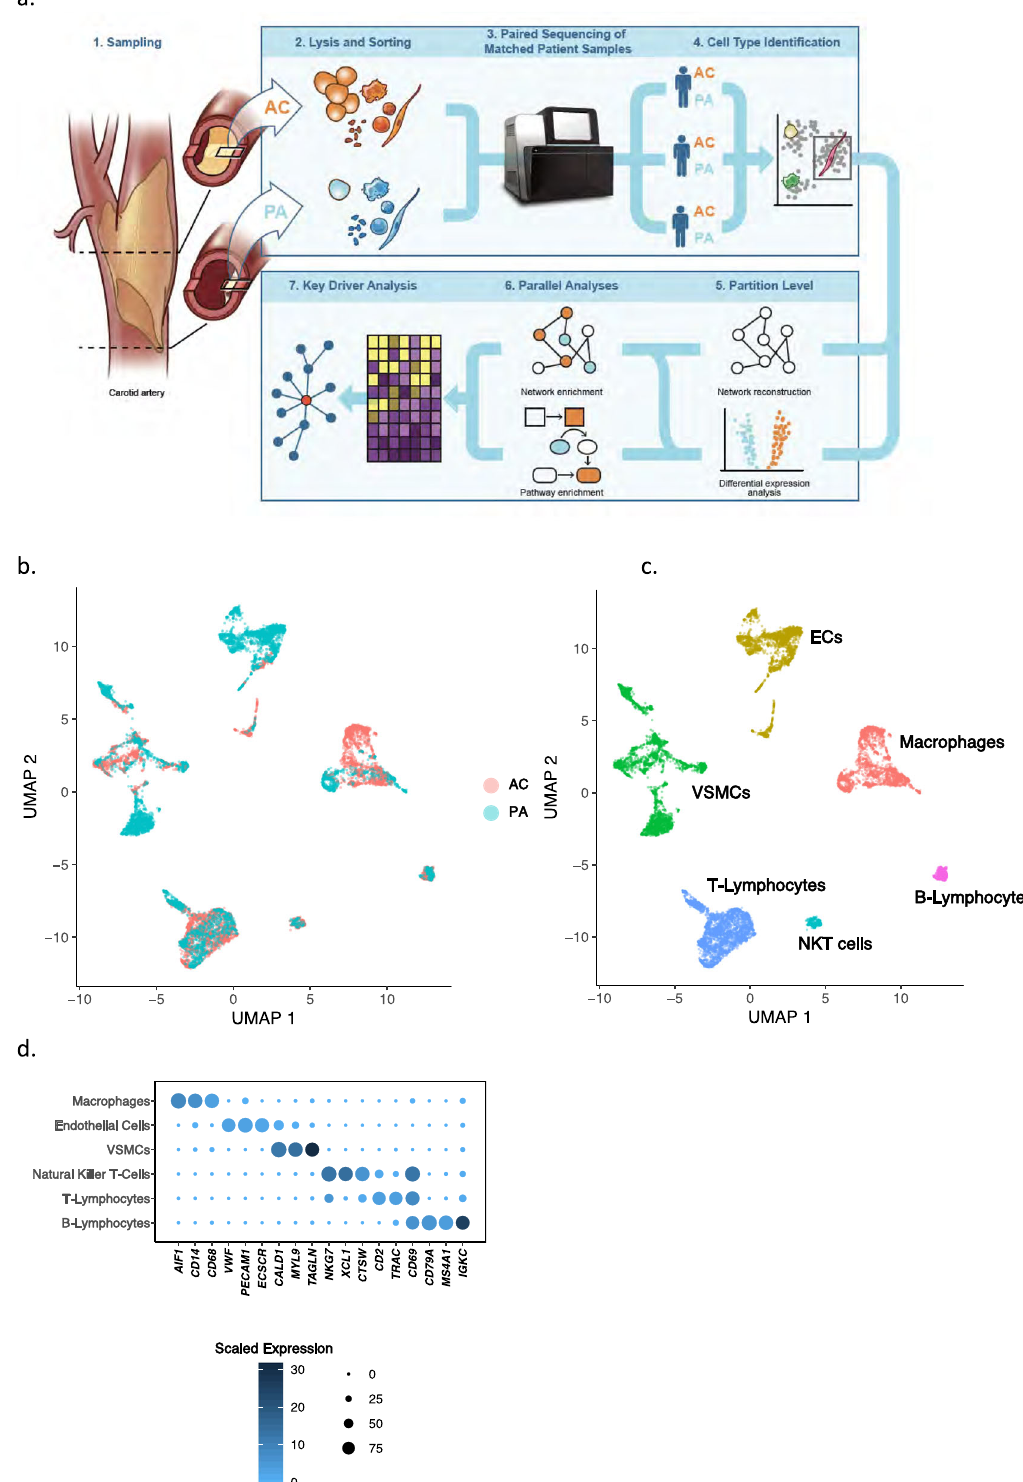
Fig. 1 Data processing produces 6 main cell group partitions. a Schematic diagram of analytical steps from tissue dissociation to key driver analysis. b , c UMAP visualization of 6 major cell types following doublet removal via gene exclusion criteria (see Supplemental Methods), separated by anatomic location ( b ), and by cell type ( c ). d Dotplot depicting cell-type marker genes, resulting in the identi fi cation of macrophages, ECs, VSMCs, NKT cells, T- and B-Lymphocytes. Dot size depicts the fraction of cells expressing a gene. Dot color depicts the degree of expression of each gene. n = 3 for PA and AC